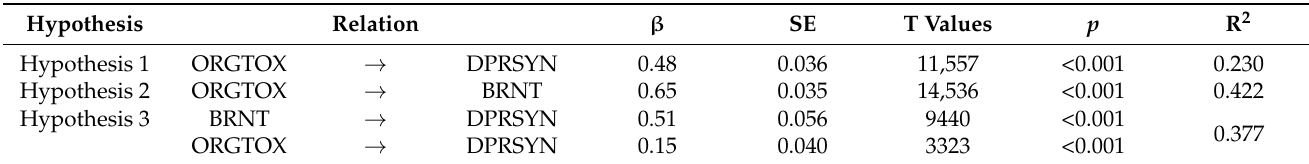
Table 5. Result of the structural model.